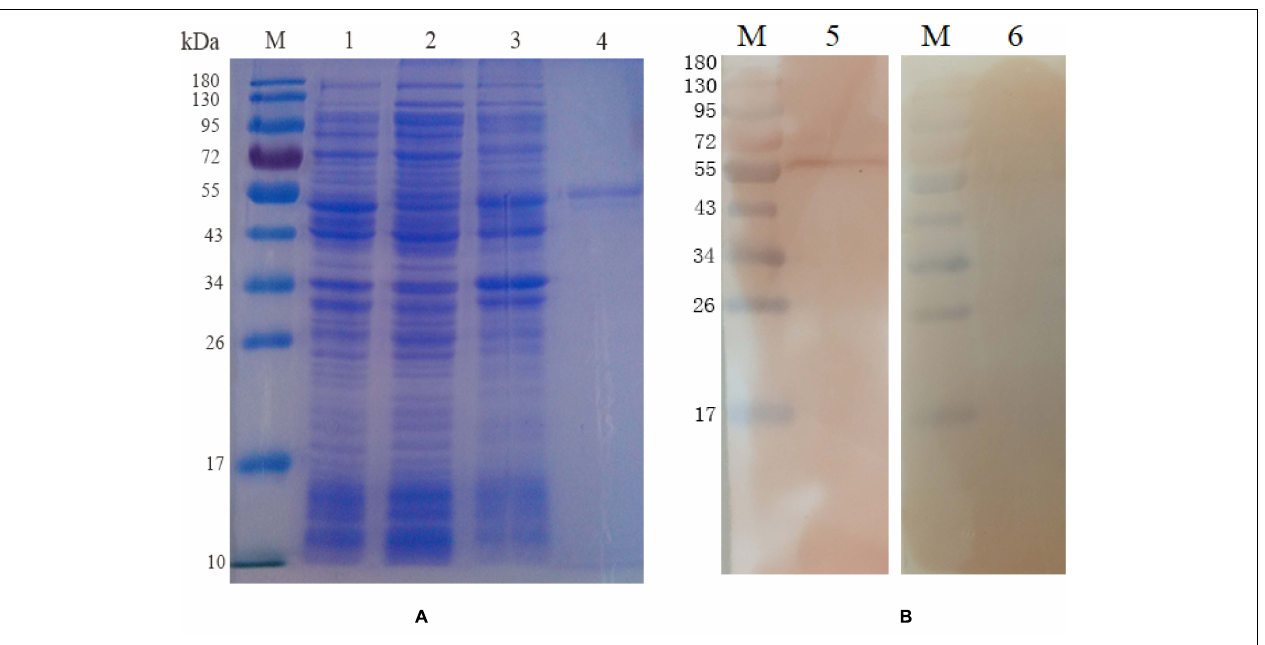
FIGURE 1 | Expression and Western blot analysis of recombinant protein pET-32a EmROM3. (A) Expression and purification of recombinant protein pET-32a EmROM3. M: protein mid-molecular weight marker. Lane 1: Expression detection of empty vector pET-32a from the cell lysate. Lane 2: Expression detection of pET-32a-EmROM3 from the supernatant of the cell lysate. Lane 3: Expression detection of pET-32a-EmROM3 from inclusion bodies of the cell lysate. Lane 4: purified recombinant protein of pET-32a-EmROM3. (B) Western blot analysis of recombinant protein pET-32a EmROM3. M: protein mid-molecular weight marker. Lane 5: The purified recombinant protein of pET-32a-EmROM3 was recognized by the chicken serum against E. maxima . Lane 6: Serum from the non-infected chicken was used as a negative